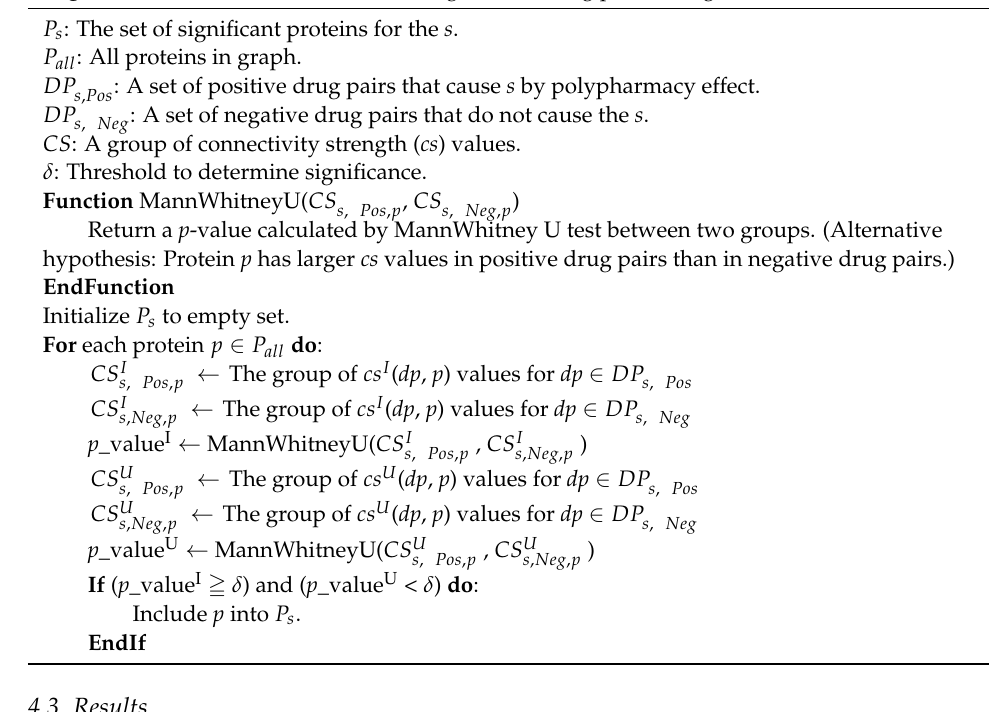
Algorithm 2. Pseudo code of determining and selecting proteins significant in a side effect s .